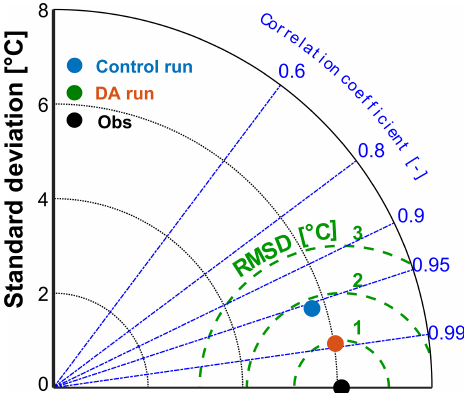
Figure 2. Taylor diagram of Lake Geneva temperature data assimi- lation. The dots correspond to the observations (black), the control run without DA (blue), and the DA run (red). The radial distance from the observations is the centered root mean square difference; the radial distance from the origin defines the standard deviation, and the azimuthal position is the correlation